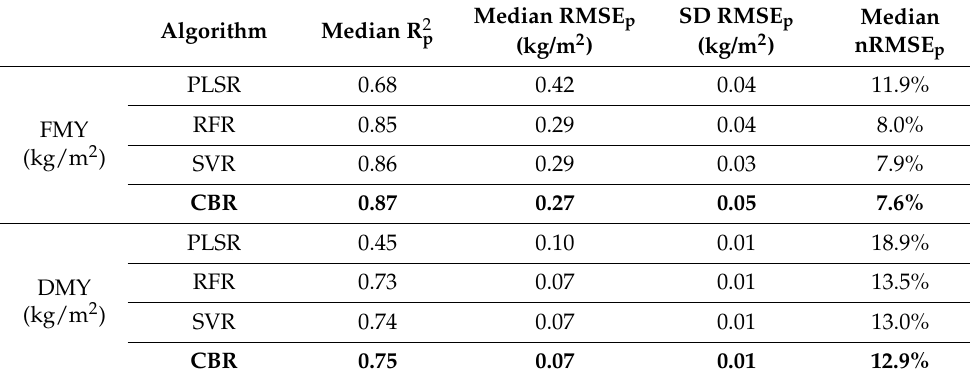
Table 3. Performance of different ML algorithms for FMY and DMY modeling. Performance figures are median values of 100 iterations with different random sample splits for calibration and validation. The best model is indicated by bold text.